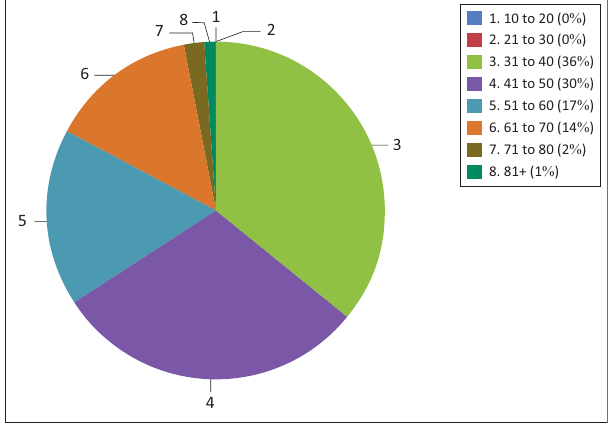
FIGURE 1: The distribution of the research participants’ ages.